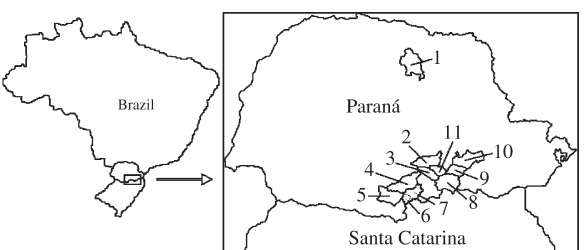
Figure 1 - Geographic localities of maize collection used in this study. 1 , Londrina, PR (accessions 5 and 50); 2 , Iratí (accessions 22, 39, 40, 42,